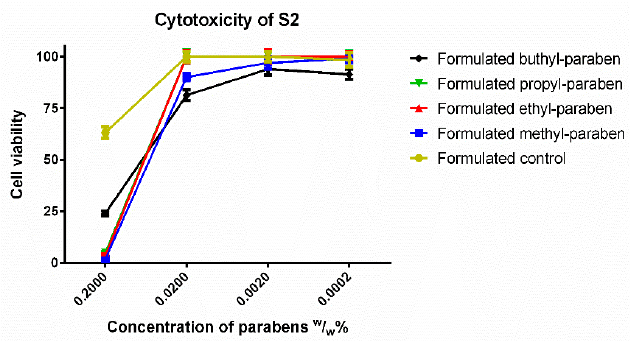
Figure 7. Cytotoxicity of the second formulated system (S2) consisting of 0.5% ( v / v ) Capryol PGMC™ and ethanol measured by MTT-assay. Cell viability expressed as the percentage of the absorbance of the untreated control cells. Data expressed as mean ± SEM, n = 12. Cell viability of the samples at 0.2000; 0.0200; 0.0020; 0.0002 ( w / w )% concentrations of different formulations containing parabens: Formulated control: 63% ± 2.8%; 100% ± 2.5%; 100% ± 2.5%; 98% ± 3.4%; formulated MP: 2% ± 0.2%; 90% ±